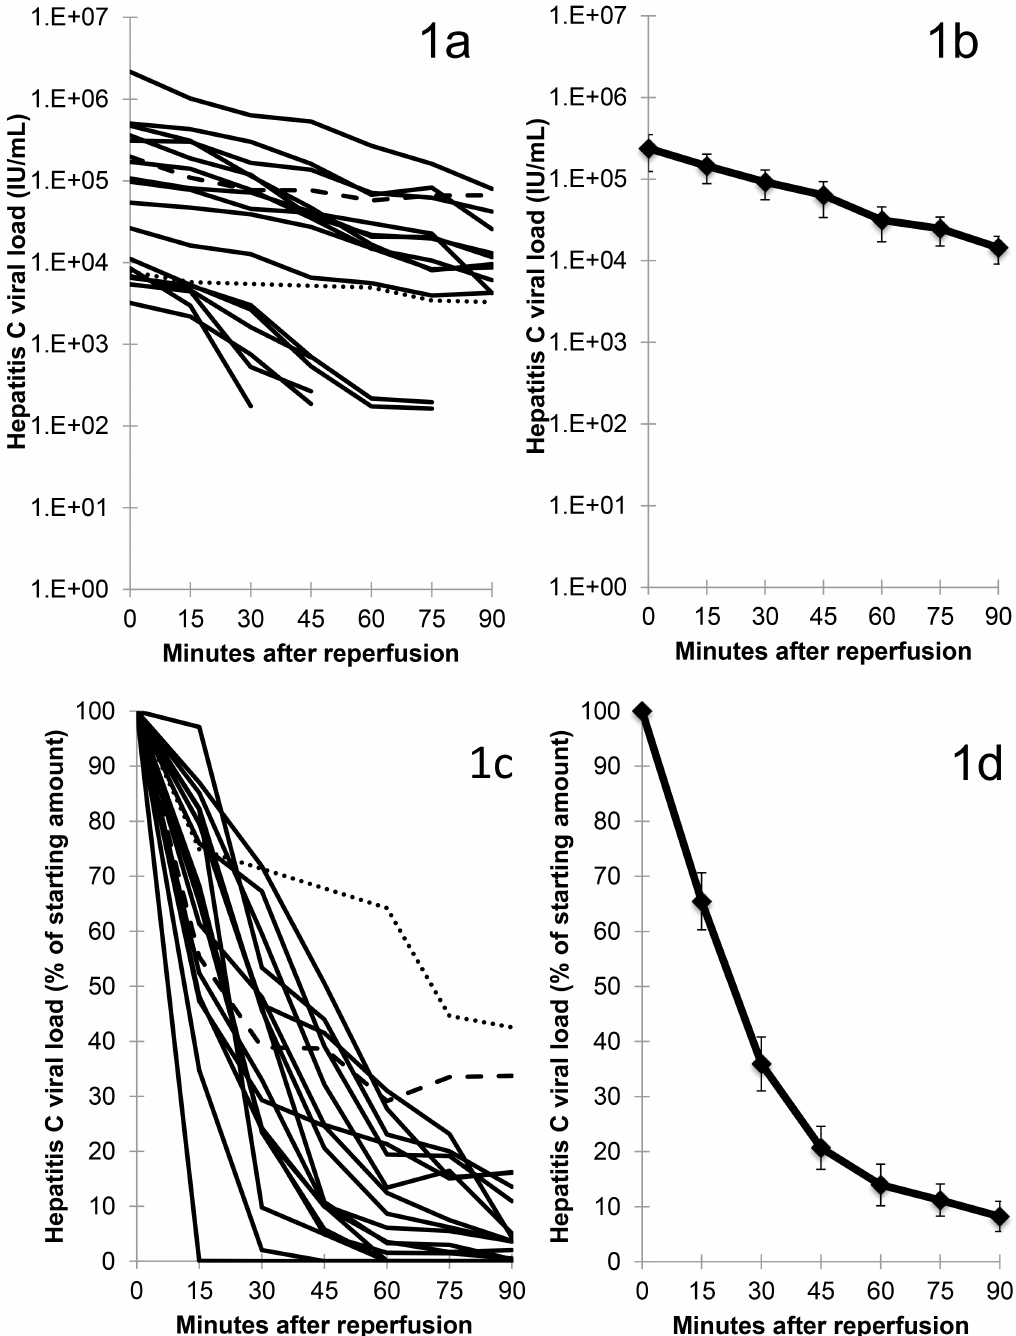
Fig 1. Allografts rapidly remove HCV from patient circulation. (A) and (C) : Each line represents an individual patient. The dotted (patient1) and dashed(patient 5) lines represent the patients with the slowest rates of viral clearance. (B) and (D) : Line represents the averageof all patients with error bars representingstandarderror. (A) and (B) : Absolutevalues for HCV are presented. (C) and (D) : HCV values relative to starting amount are presented. Duringreperfusion,the rate of viral clearance varied more than 20-fold with a median rate constant of 0.0357 1/minute (range 0.0089–0.2169 1/minute) and medianhalf-life of 19.4 minutes (range 3.2–77.8minutes).